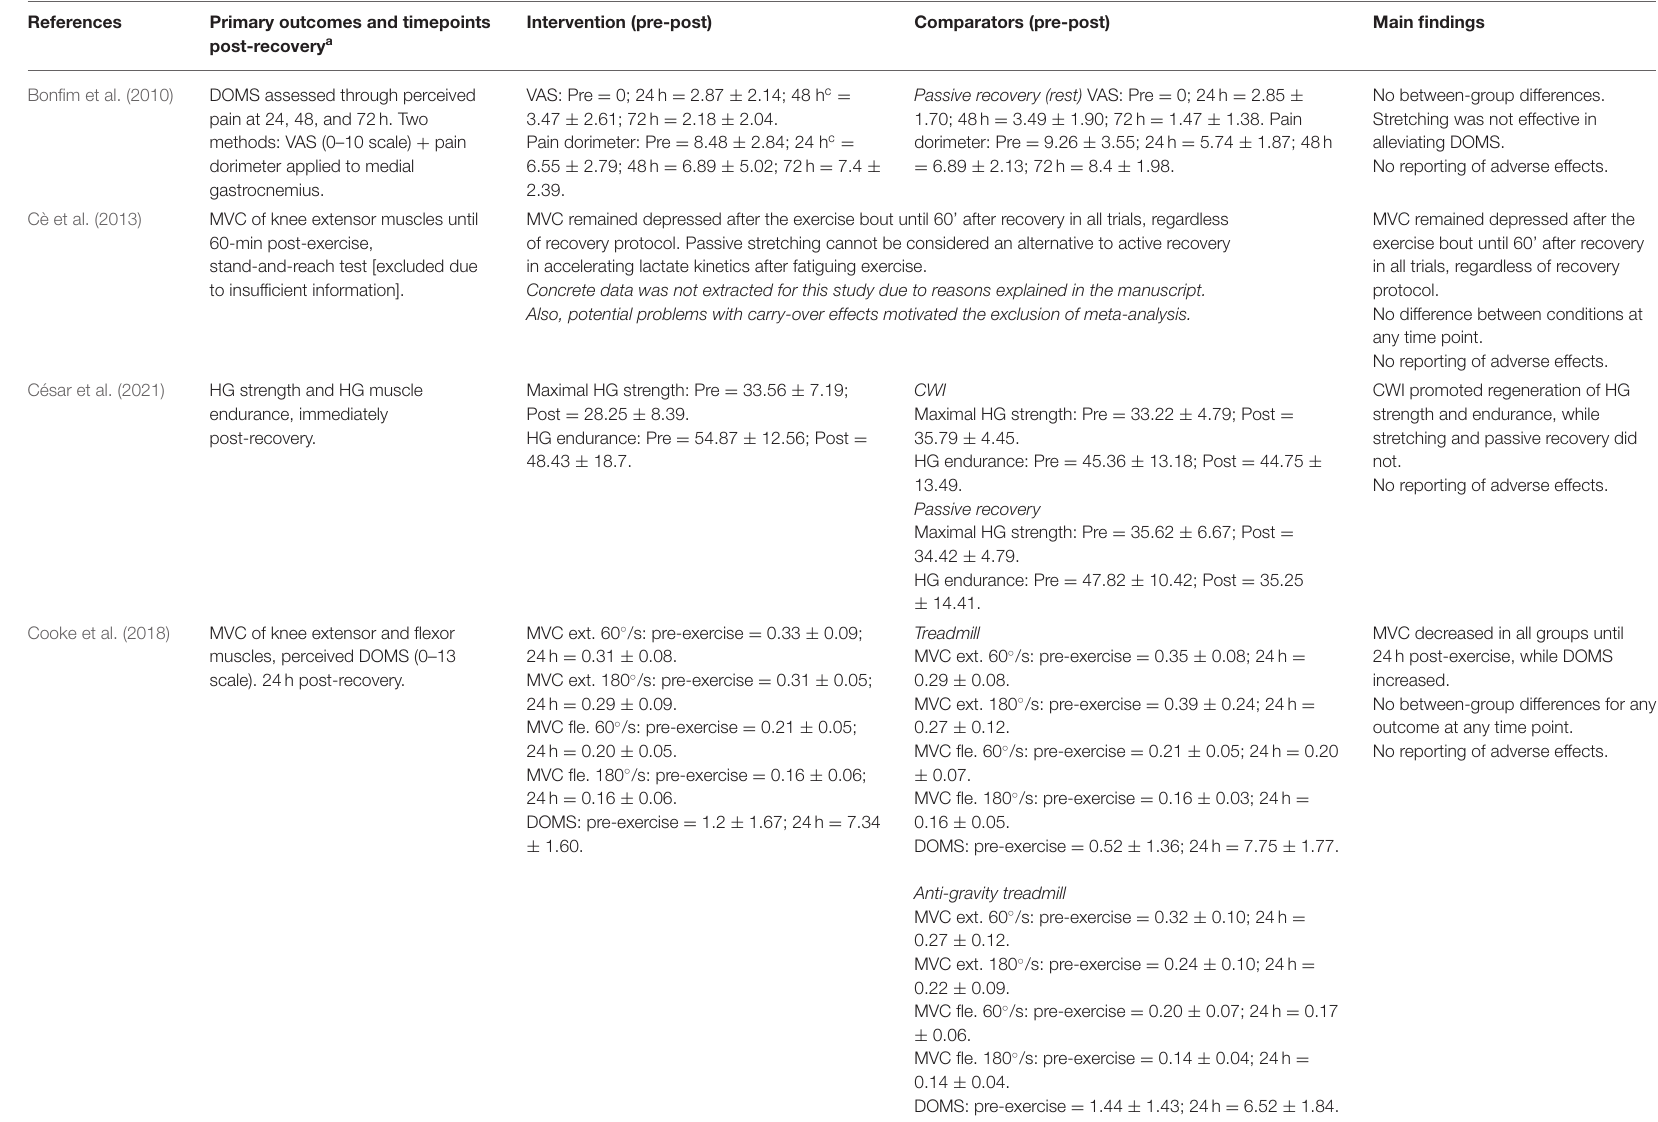
TABLE 4 | Results of individual